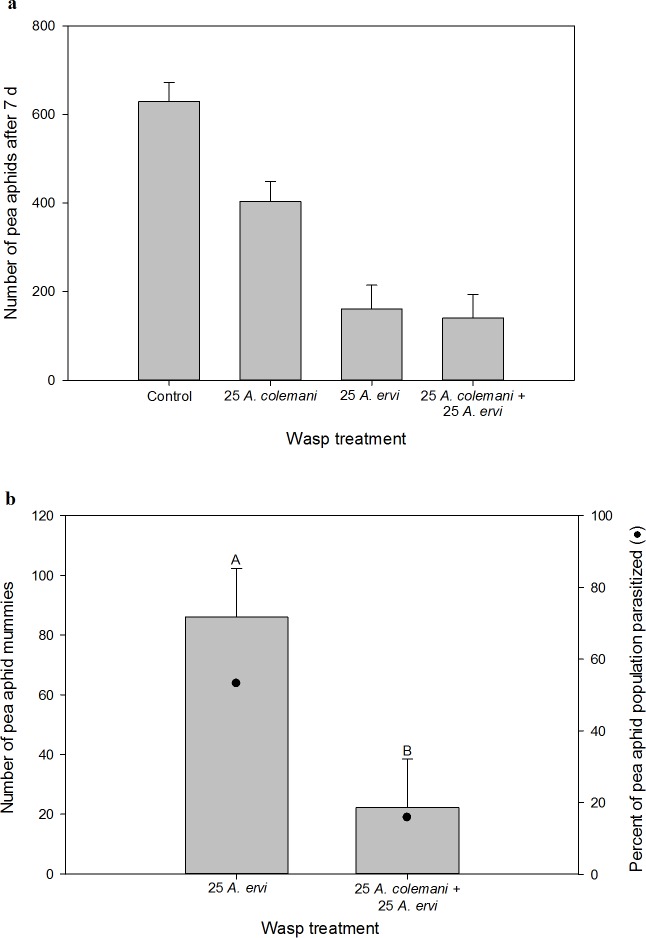
Experiment 1, pea aphids.(a) The non-consumptive effect of parasitoid treatment on pea aphid abundance seven days after parasitoid introduction. LS means + 1 SEM for all treatments are shown, but no comparisons of means were performed because the interaction was not significant (main effect of A. ervi p < 0.05, main effect of A. colemani p < 0.10). (b) The consumptive effect of parasitoid treatment on pea aphid abundance, measured by the production of mummies (grey bars) and percent parasitism of the pea aphid population (●). Aphidius ervi parasitizes pea aphids and A. colemani does not. Only treatments where pea aphid mummies formed are shown. LS means + 1 SEM are shown. Letters indicate significant differences at the α = 0.05 level.